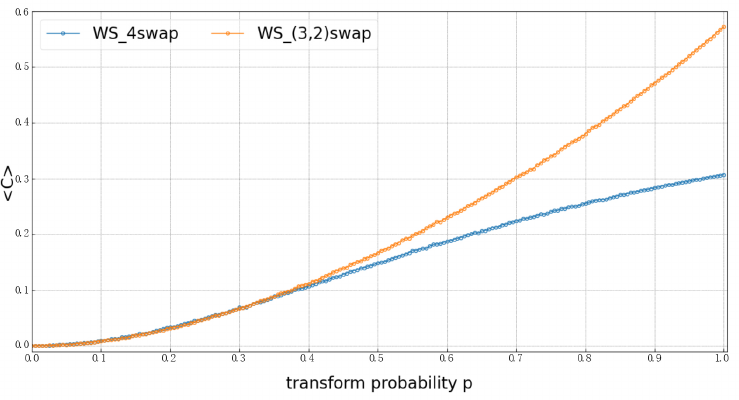
Figure 8. Distribution of network clustering coefficients obtained with different